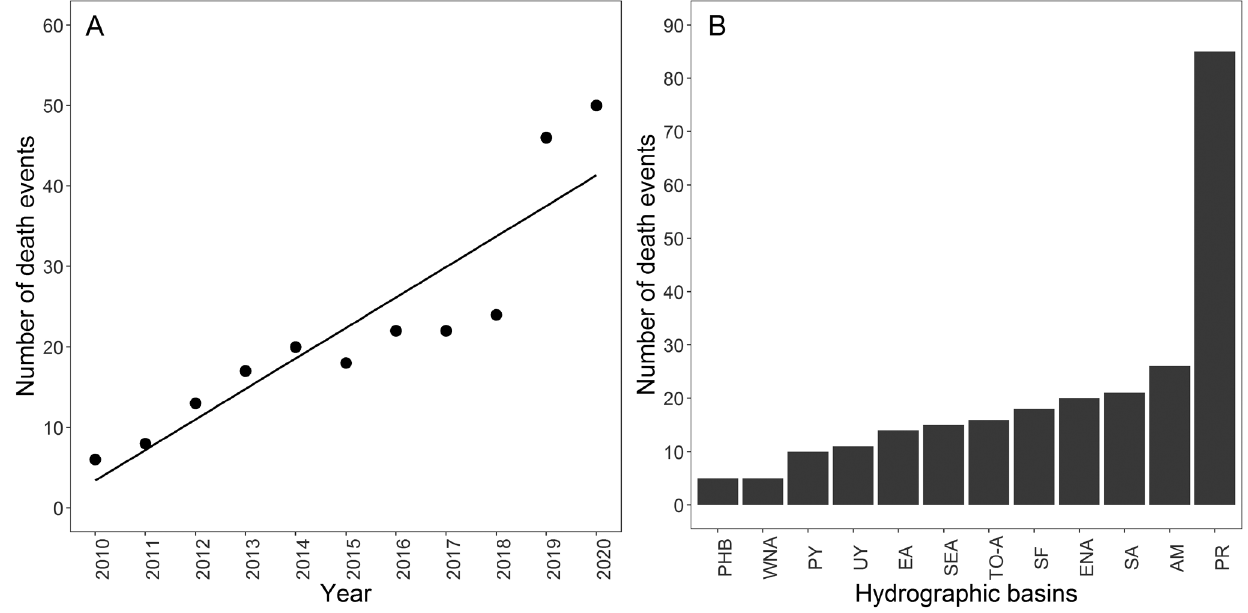
FIGURE 5 | Fish mortality events between 2010 and 2020 ( A ) and in different Brazilian hydrographic basins ( B ), as reported by news (Google searches). PHB = Parnaiba, WNA = Western Northeast Atlantic, PY = Paraguay, UY = Uruguay, EA = East Atlantic, SEA = Southeast Atlantic, TO-A = Tocantins-Araguaia Basin, SF = San Francisco, ENA = Eastern Northeast Atlantic, SA = Southeast Atlantic, AM = Amazon, PR = Paraná.